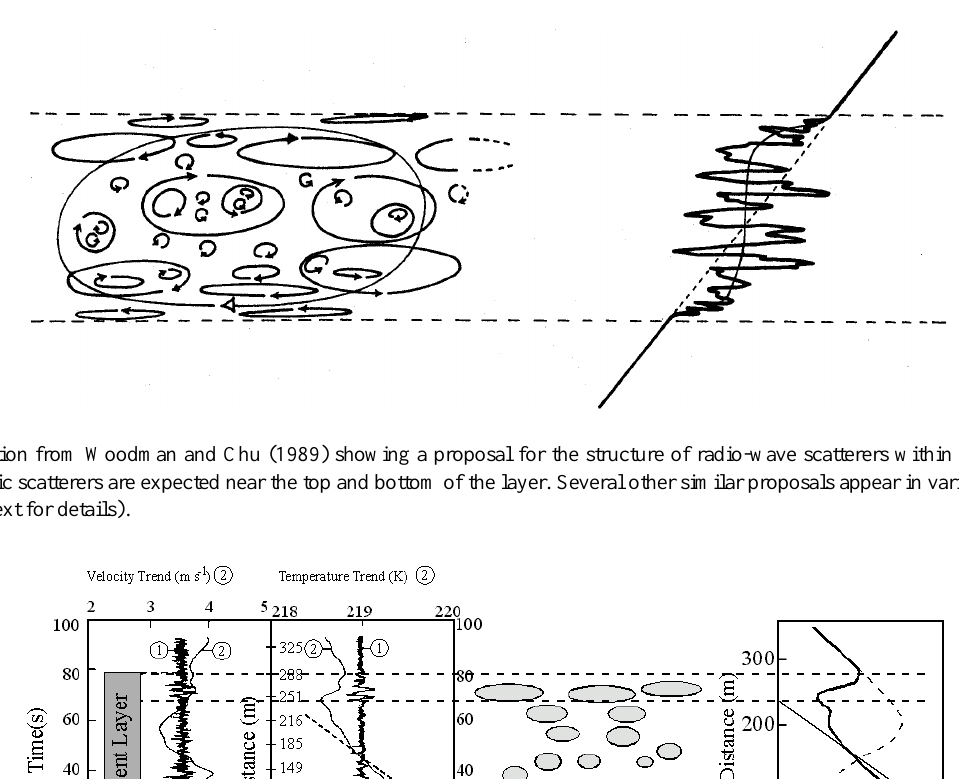
ter are neither exclusively turbulent, nor exclusively